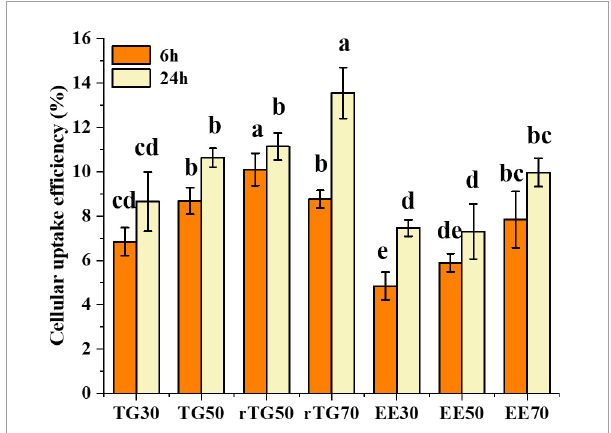
FIGURE6 Cellular uptake of EPA/DHA as TGs and EEs after incubation for 6 h and 24 h. Data represent mean ± SD ( n = 3). Different letters (a, b, c, and d) indicated statistically significant differences among different groups by ANOVA ( p < 0.05).